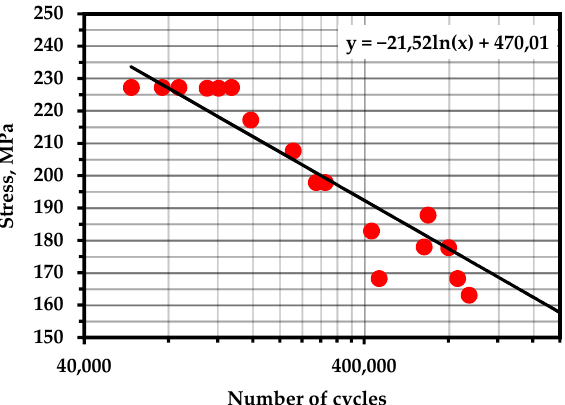
Figure A12. S–N Curve—Steel С 55 (accepted as an analogue) (Temperature—293 К ; frequency—30 Hz) [105].